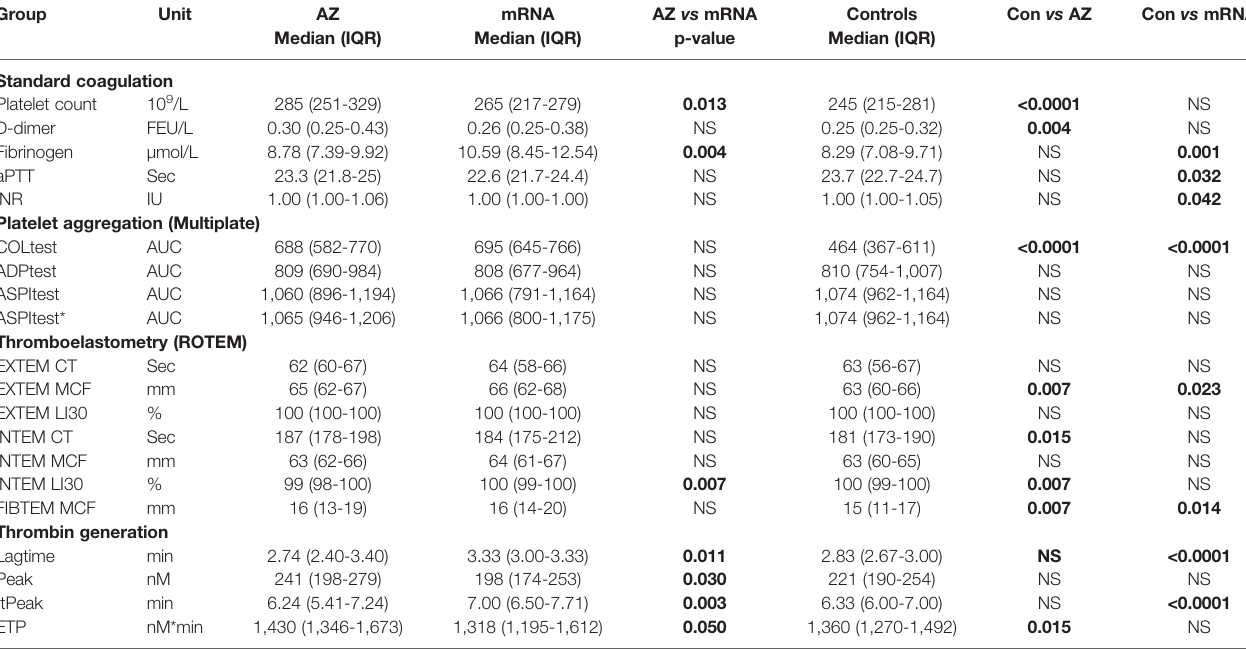
TABLE 1 | Coagulation, primary and secondary hemostasis and thrombin generation post-vaccination either AZ (n=55) or mRNA (n=25) vaccines and in non-vaccinated age and gender matched controls (n=55). Group